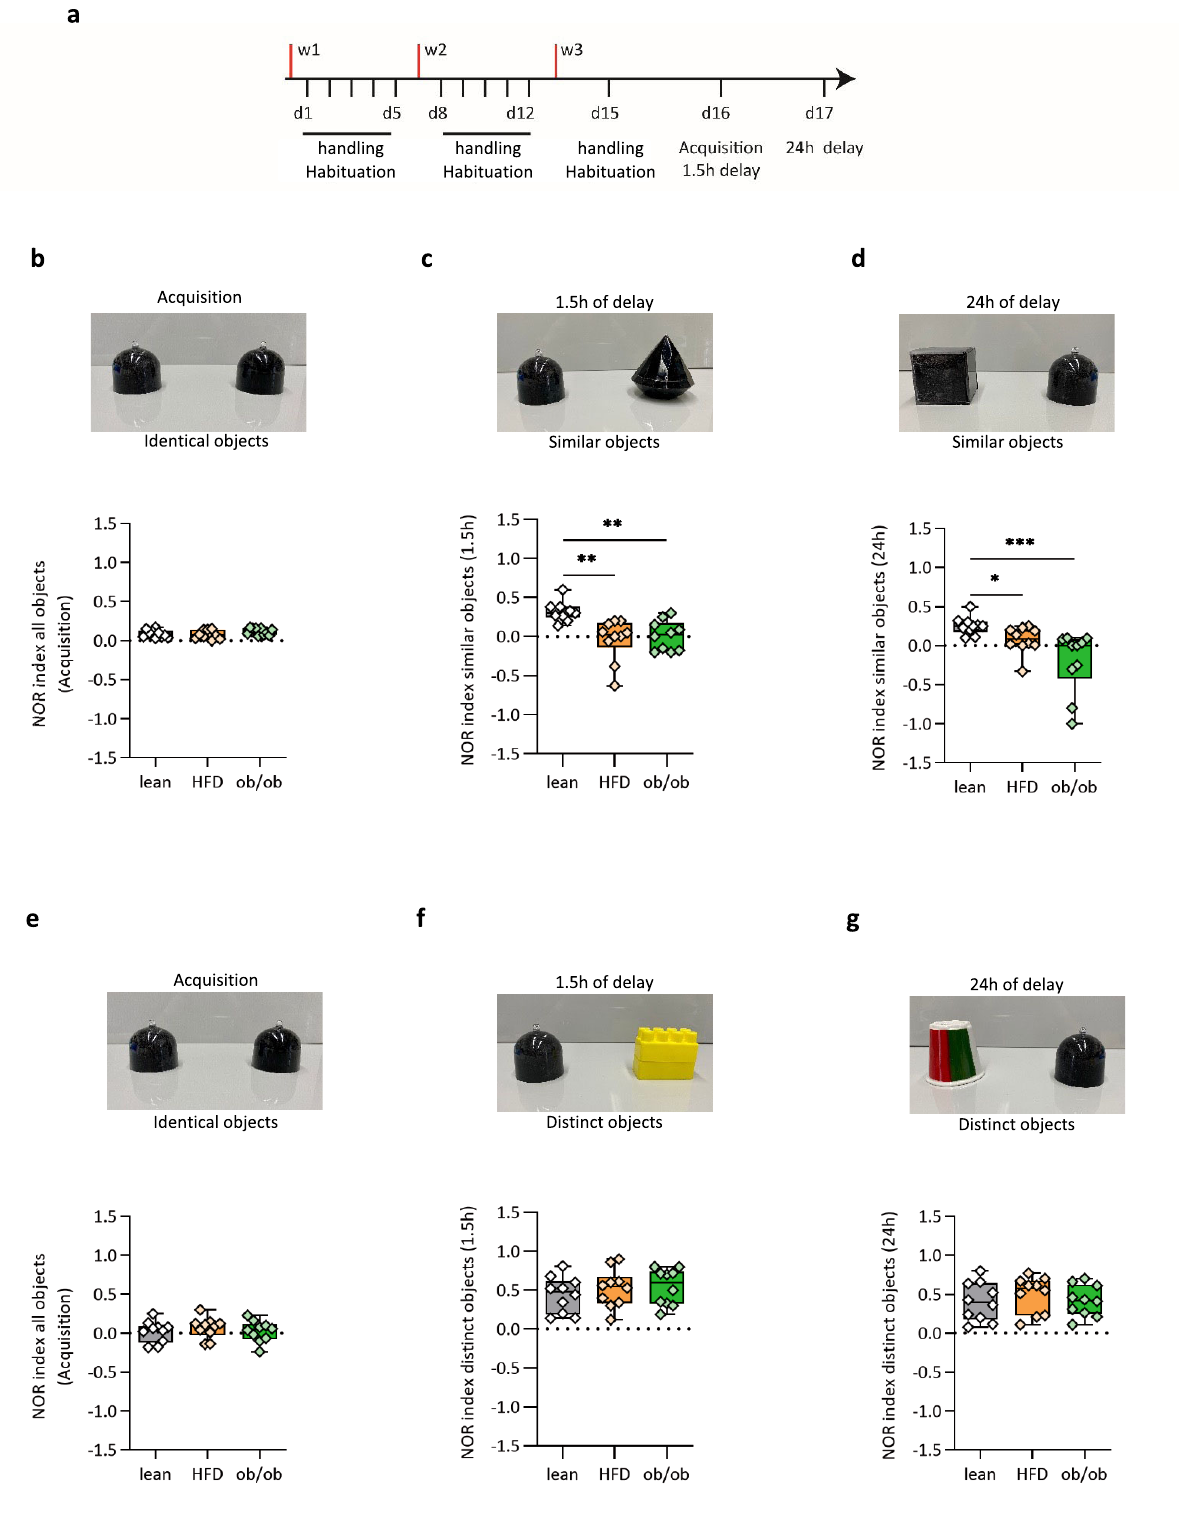
we found a very similar time of exploration for lean, HFD, and ob/ ob mice during the study phase (NOR-discrimination index: mice per group, Fig. 1b). These data suggest that the animals do not show a bias towards the right or left side. Novel object recognition was tested by substituting the new object with a similar object with the same color, but different shape. Obese mice showed a signi fi cant